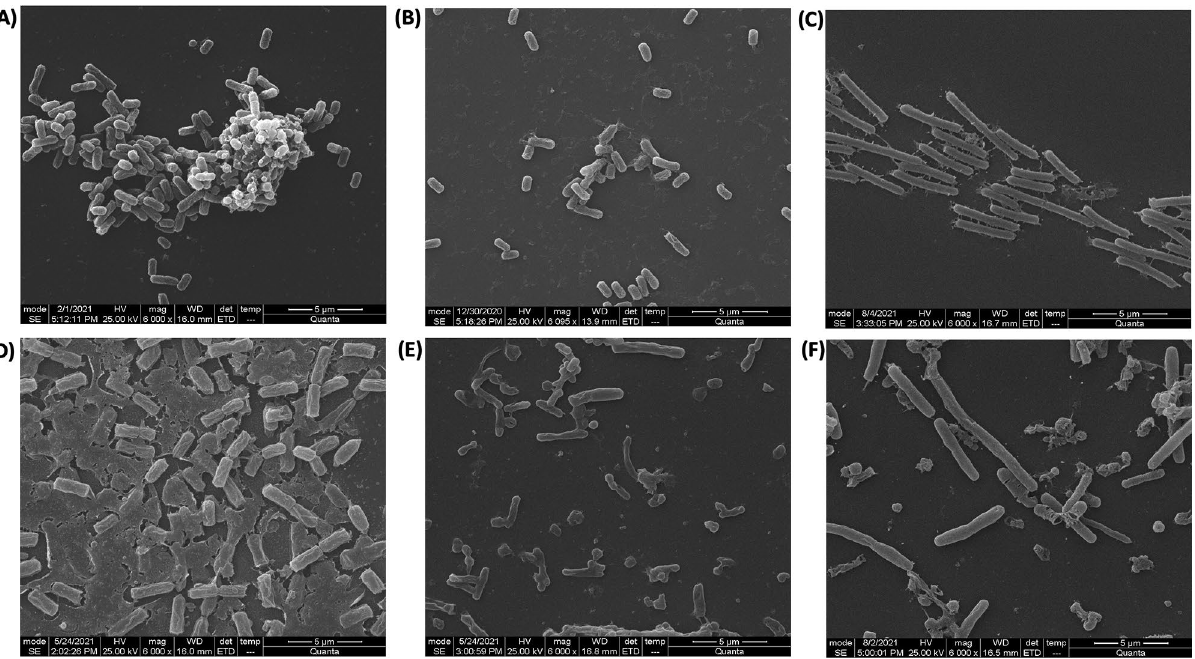
Figure 5. Scanning electron micrograph of biofilm formation and degradation assay. ( A ) 24 h untreated control, ( B ) 24 h biofilm treated with phage Sfk20, ( C ) 24 h biofilm treated with the combination of phage Sfk20 and ampicillin, ( D ) 48 h untreated control, ( E ) 48 h biofilm treated with phage Sfk20, ( F ) 48 h biofilm treated with the combination phage Sfk20 and